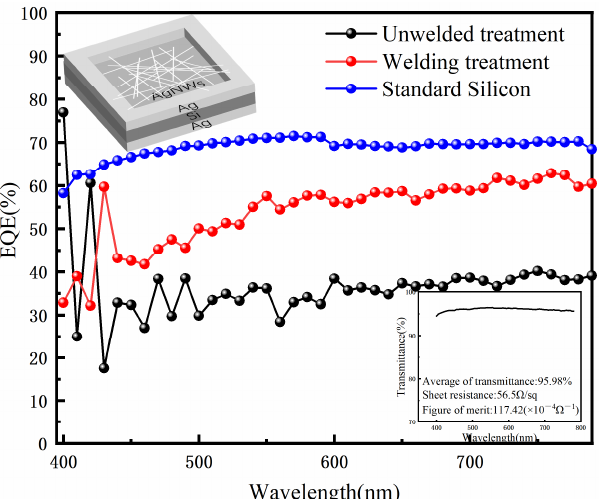
Figure 7. Comparison of quantum efficiency of silicon devices before and after the UV welding.